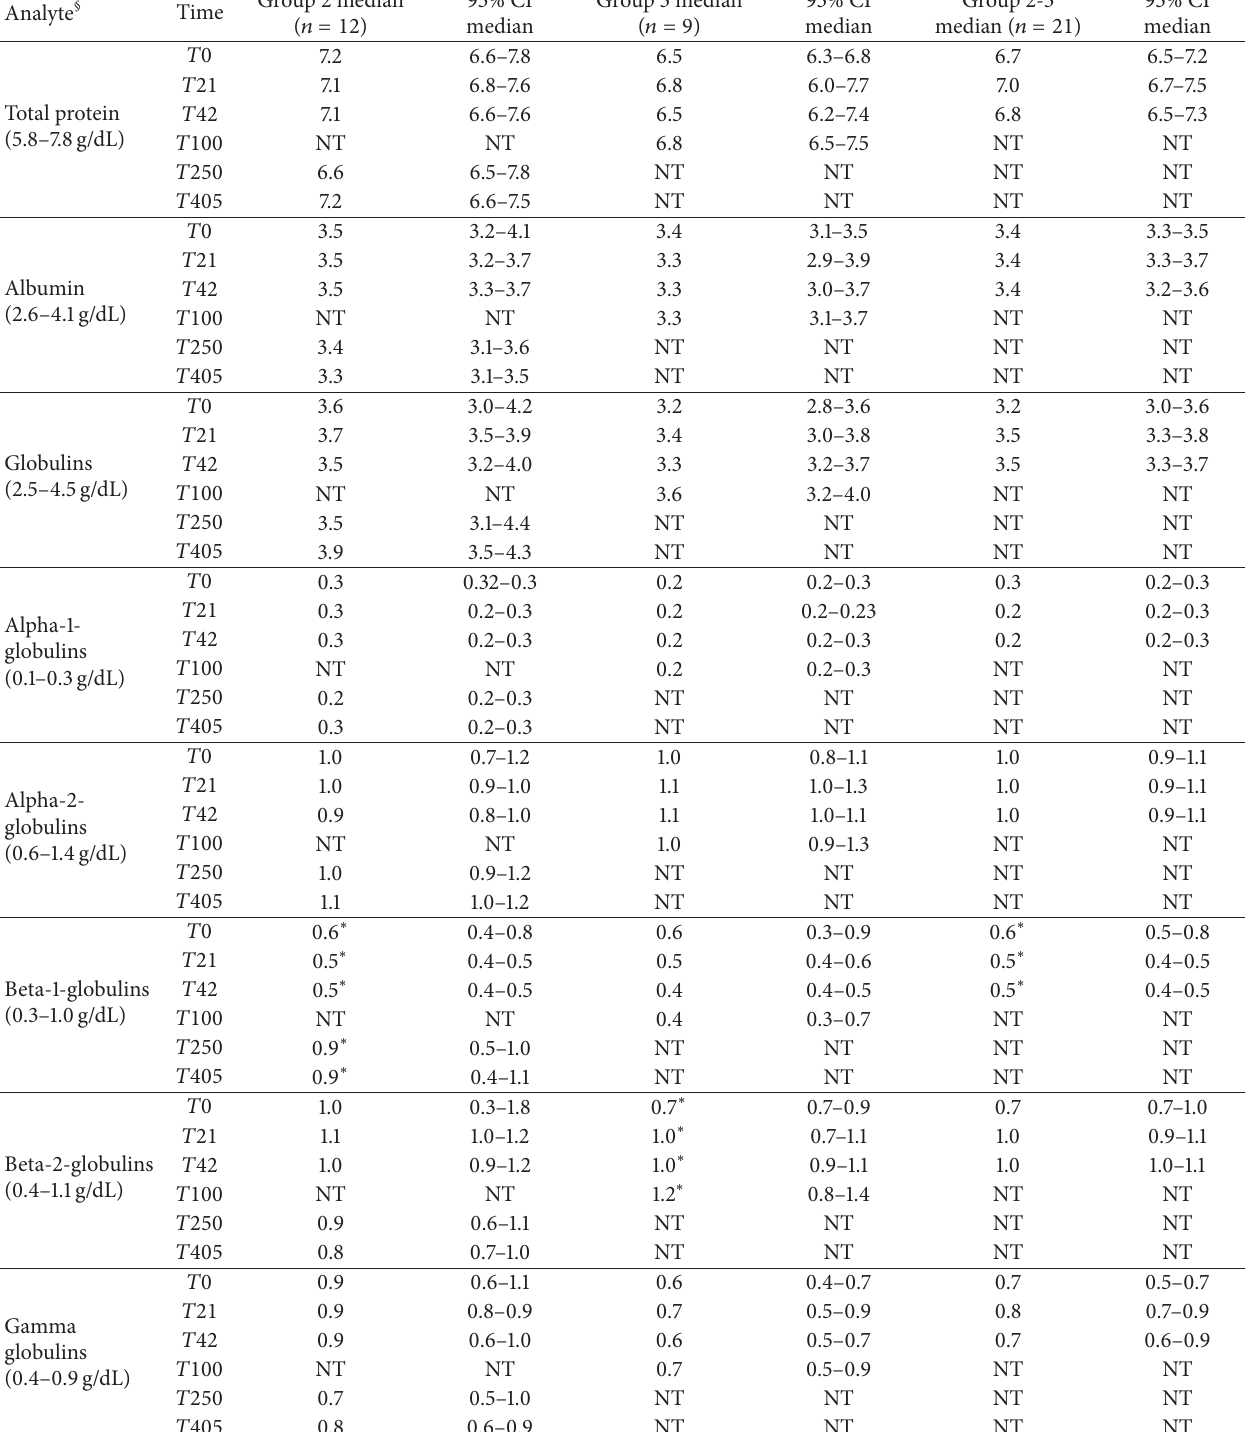
Table 1: Major serum proteins and electrophoresis fractions reported as absolute values in Groups 2 and